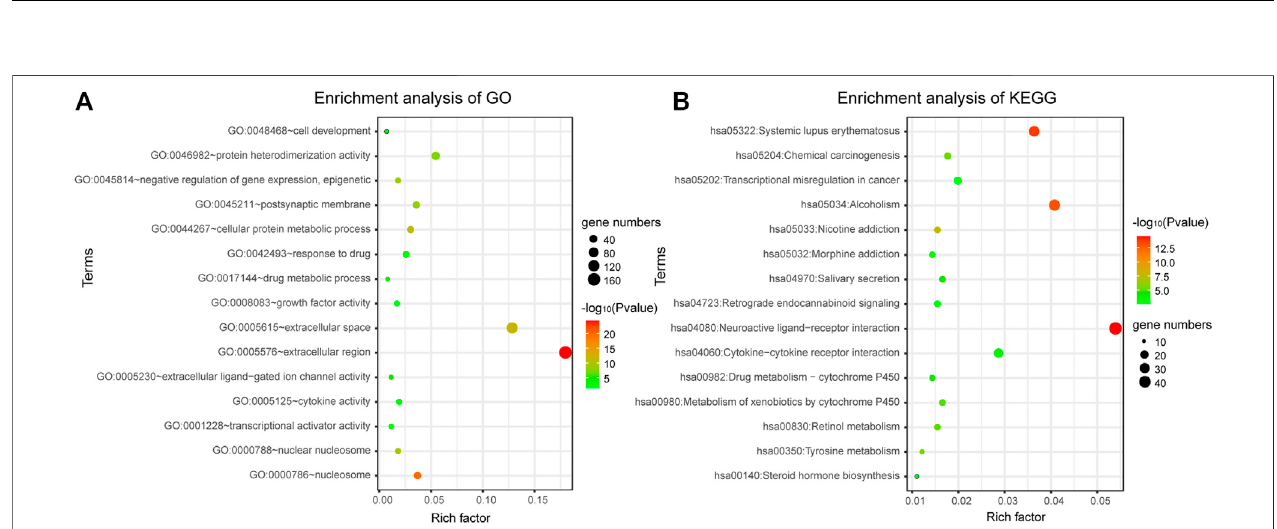
FIGURE 2 | Gene enrichment analysis. (A) Gene enrichment analysis of Gene Ontology. (B) Gene enrichment analysis of KEGG.